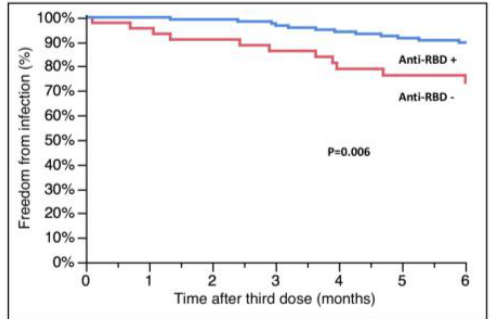
Figure 4. Relationship between anti-RBD antibodies after the third dose of vaccine and subsequent SARS-CoV-2 infection. RBD: receptor-binding domain. cantly lower value of anti-RBD antibodies (385 (IQR 0.4-2500) vs. 1327, (IQR 79-2500), no MMF vs. MMF, p = 0.02) and less frequently a positive antibody response (65.8% vs.